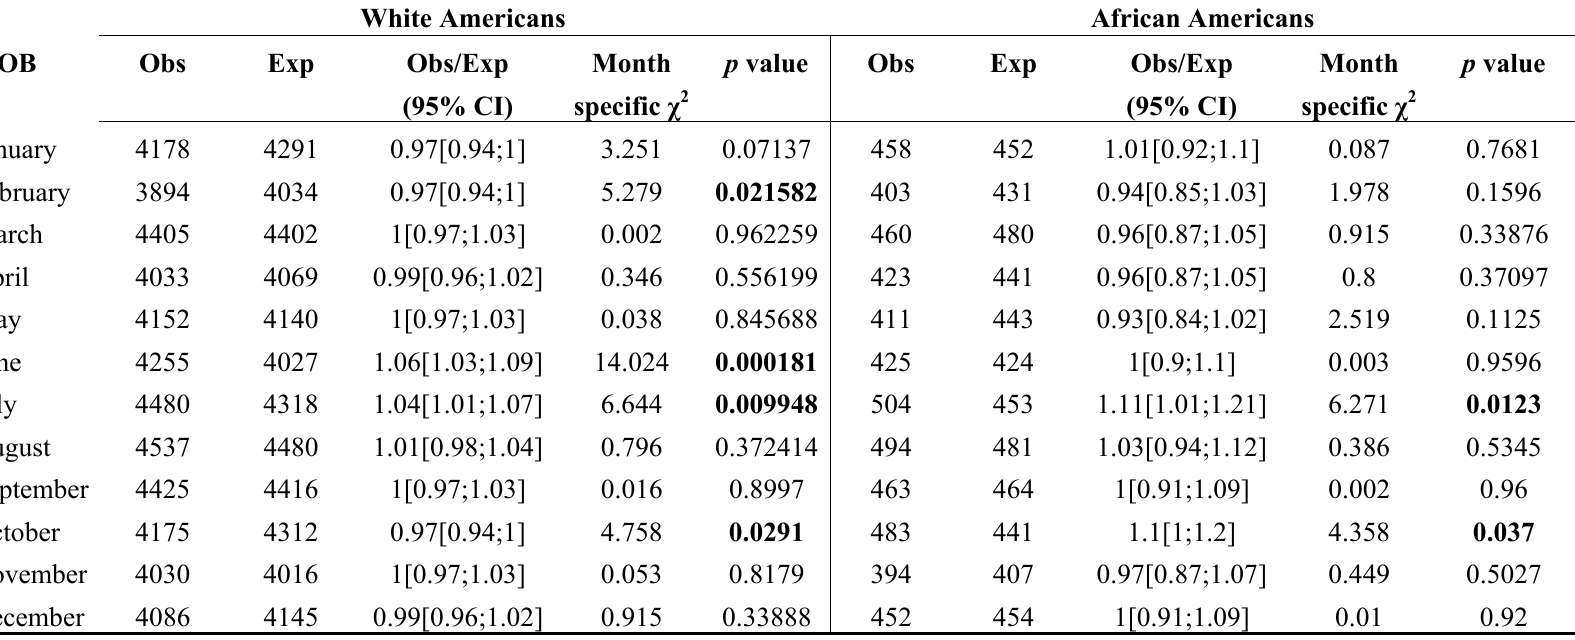
Table 3. Seasonality overall results for U.S. data normalized for the population based controls. White Americans African